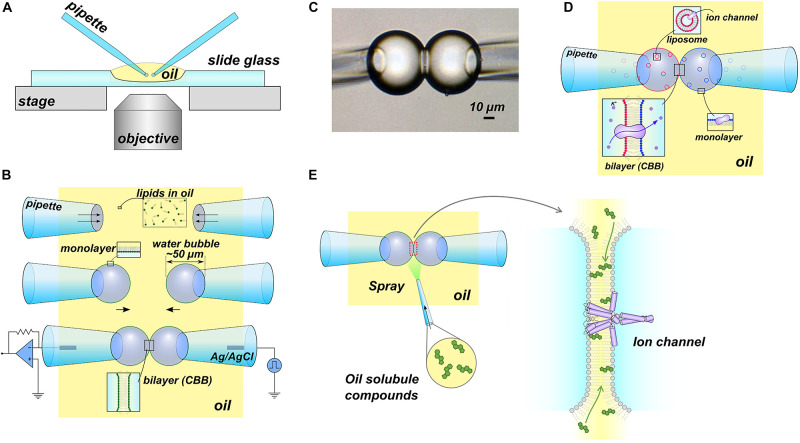
The contact bubble bilayer (CBB) experiments. (A) Overview of the CBB experimental setup. All experiments were performed using an inverted microscope. (B) Schematic illustration of the CBB formation procedure. In the simplest case, phospholipids are contained in the oil phase (e.g., 20 mg/mL azolectin in hexadecane). Two glass pipettes filled with electrolyte solutions were dipped into the lipid-containing oil (top), and a water bubble was inflated at the tip of the glass pipettes (middle). Lipid molecules in oil are spontaneously distributed at the interface between the oil and the electrolyte, forming a lipid monolayer. The two bubbles are brought into contact with each other and form a CBB (lower). (C) Photograph of CBB. (D) Schematic illustration of asymmetric CBB formation. To form an asymmetric lipid bilayer, each bubble formed with lipid-free oil (hexadecane) should contain liposomes (depicted by blue or red circles) with a different lipid composition. (E) Scheme for “membrane perfusion.” In the DIB methods, including the CBB method, the bilayer interior is open to the bulk oil phase. Thus, the injection of hydrophobic substances (e.g., cholesterol) in the oil phase transfers the substance to the lipid bilayer (membrane perfusion). The illustrations in (A–D) (Iwamoto and Oiki, 2015) and (E) (Iwamoto and Oiki, 2017) are modified from the original papers, respectively.